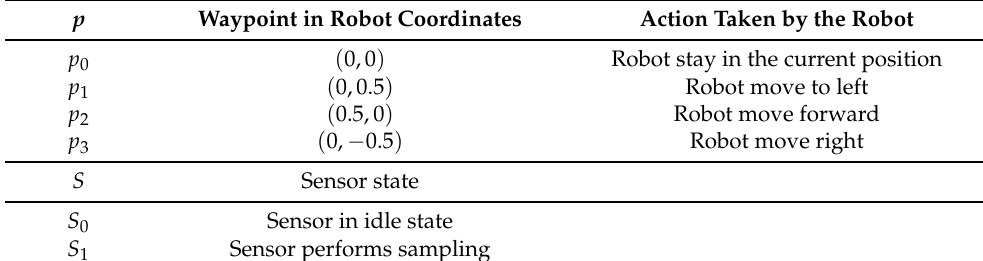
Table 1. The list of actions done by the robot p , and audit sensor state S